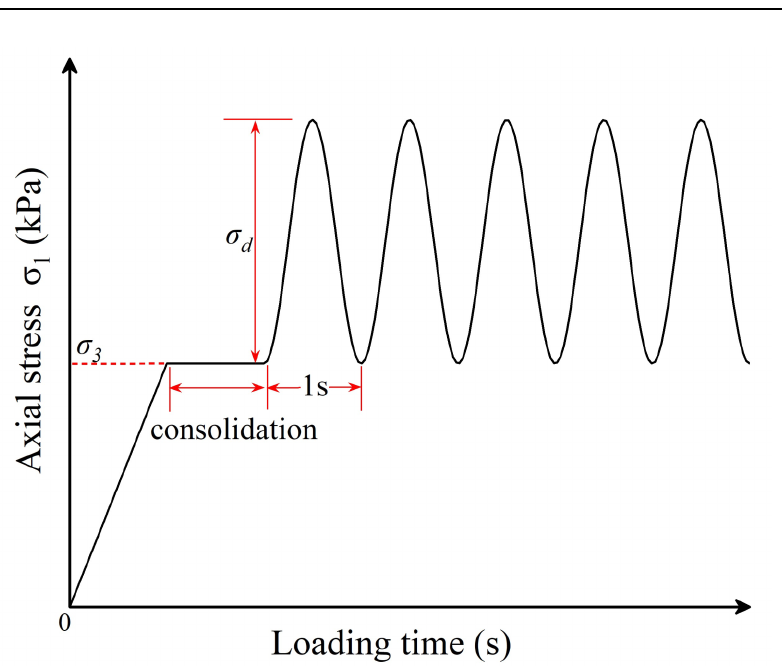
Figure 7. The time–history curve of axial stress applied during the laboratory repeated-load triaxial tests. Each of the 15 sequences included 100 repeated load applications. If the accumulated plastic axial strain of the specimens exceeded 5% during loading, the tests were then terminated. The resilient modulus corresponding to each of the last five load applications of each repeated-loading sequence was calculated via Equation (5) as illustrated in Figure 8. The average value of the resilient moduli of the last five load applications was taken as the representative value of the resilient moduli of each sequence of repeated loading (or equivalently each combination of stress